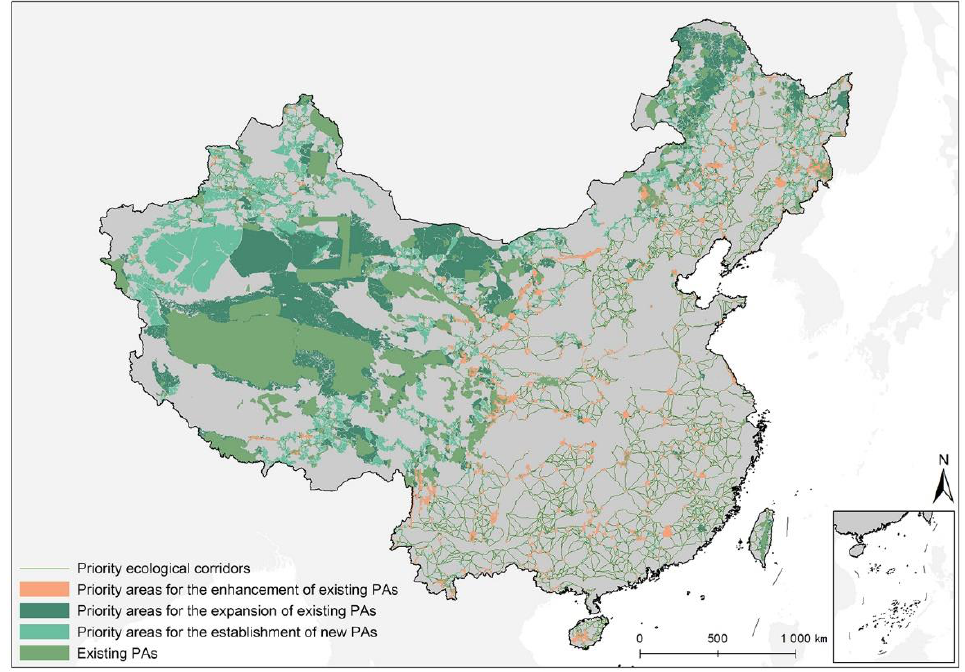
Figure 4. Spatial priority area to improve PA connectivity in China, including priority ecological corridor, priority areas for the enhancement of existing PAs., the expansion of existing PAs and the establishment of new